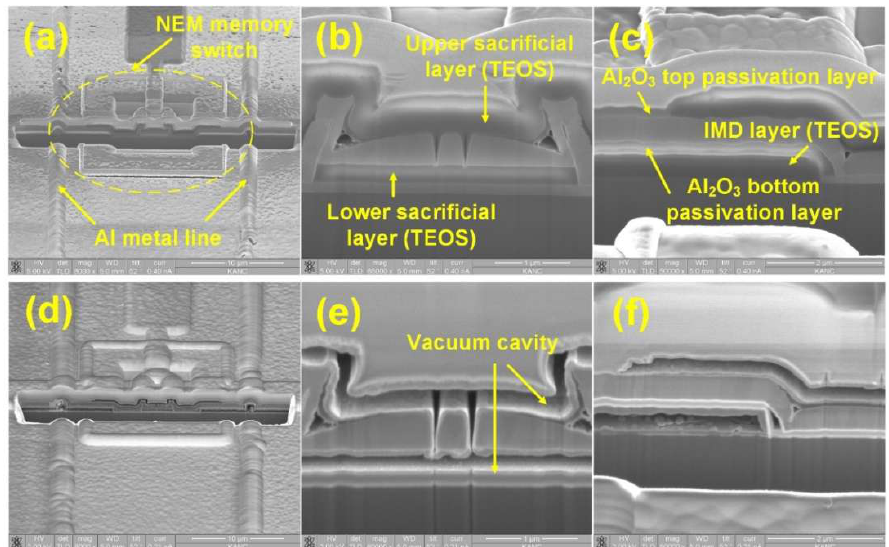
Figure 4. ( a ) Nanoelectromechanical (NEM) memory switch and metal interconnection lines, ( b ) NEM memory switch and ( c ) metal interconnection lines before vapor hydrogen fluoride (HF) etching. ( d ) NEM memory switch and metal interconnection lines, ( e ) NEM memory switch and ( f ) metal interconnection lines after vapor HF etching.